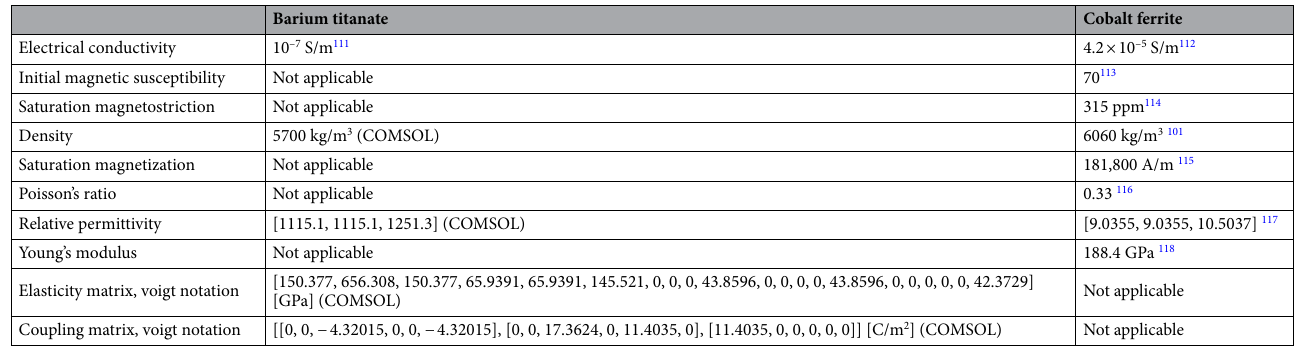
Table 1. Parameter values and respective sources for all material constants used within